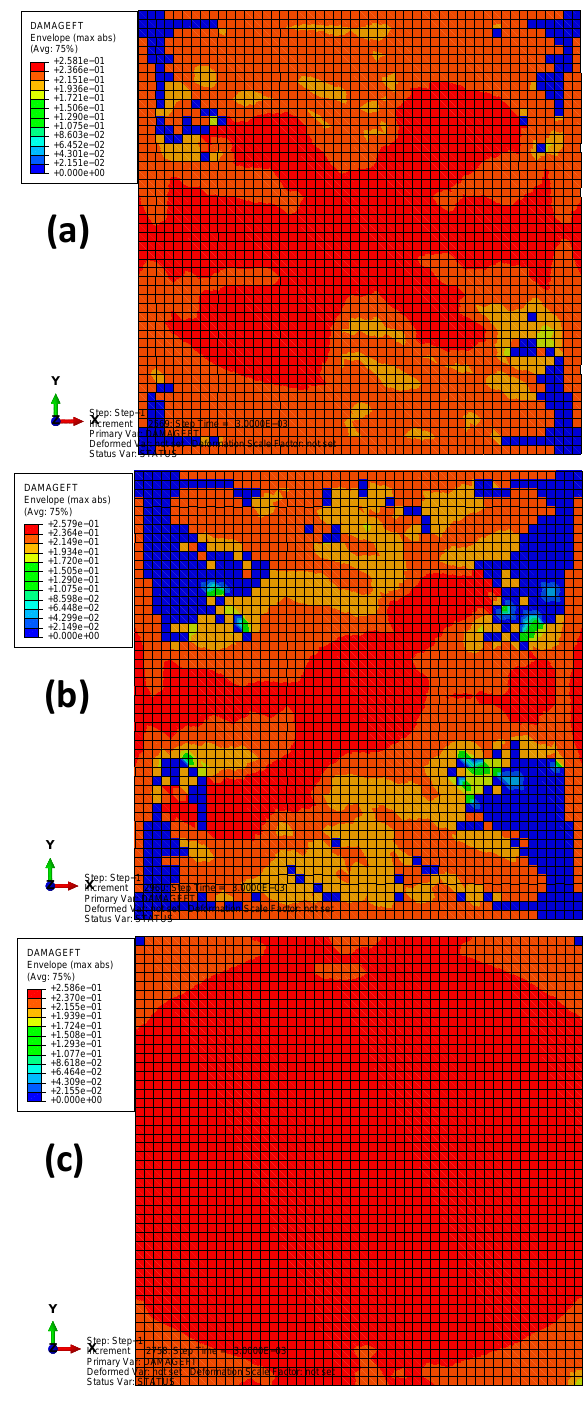
Figure 8. The fiber tension damages of the three models after bird impact: ( a ) material 1; ( b ) material 2; ( c ) material 3.